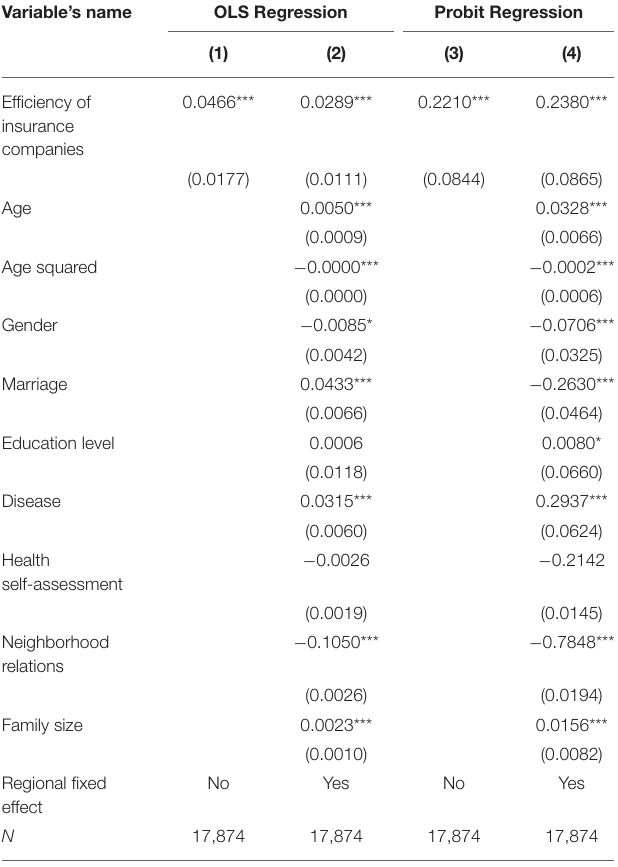
TABLE 5 | Robustness test regression